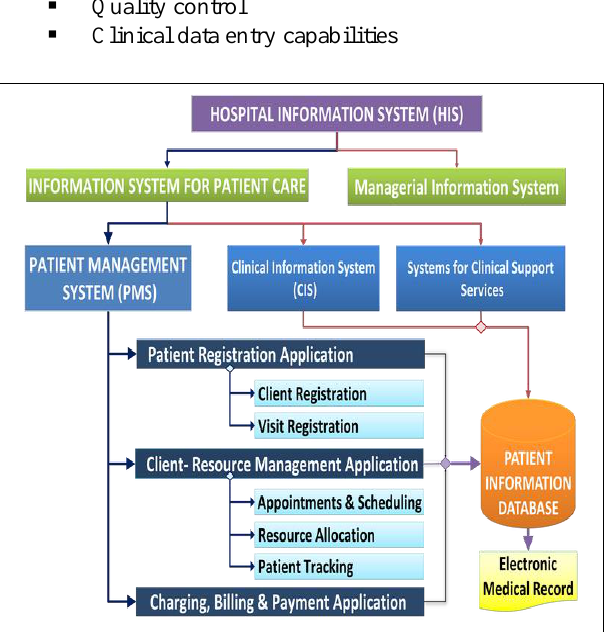
Figure 4. Patient Management Systems Architecture